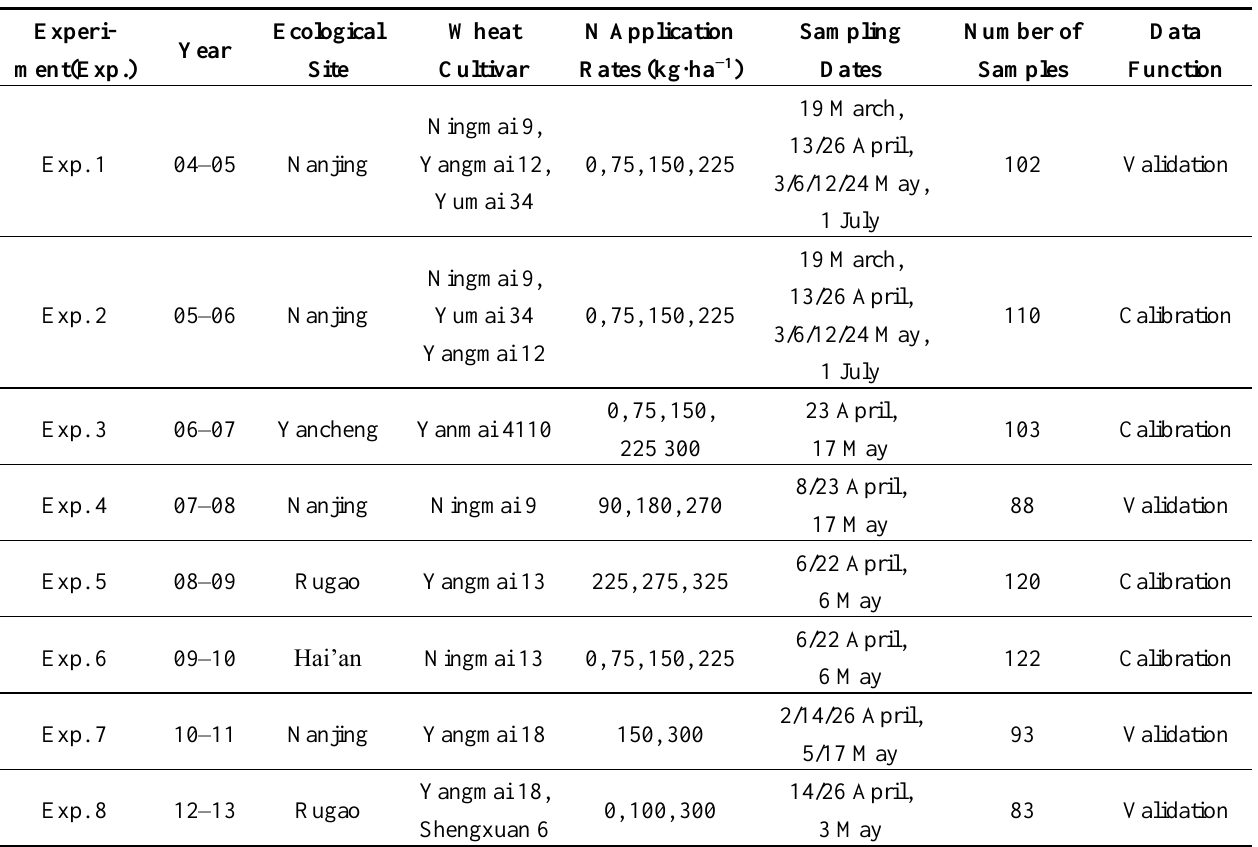
Table 1. Details of the eight field